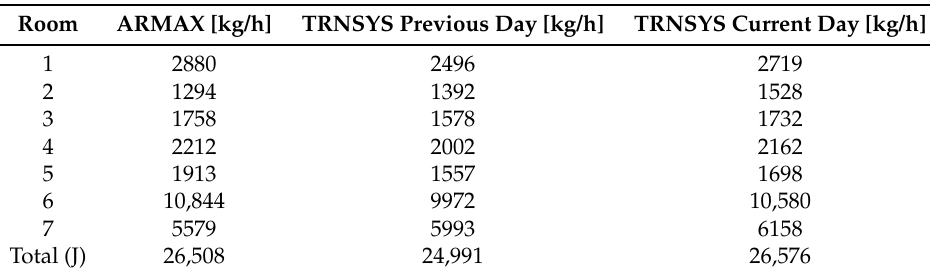
Table 8. Radiators Performance index value (4) for the unoccupied room case with the ARMAX model and with the TRNSYS model using weather conditions of the previous days (4 December i.e., those used by the genetic algorithm) and of the current day (5 December).